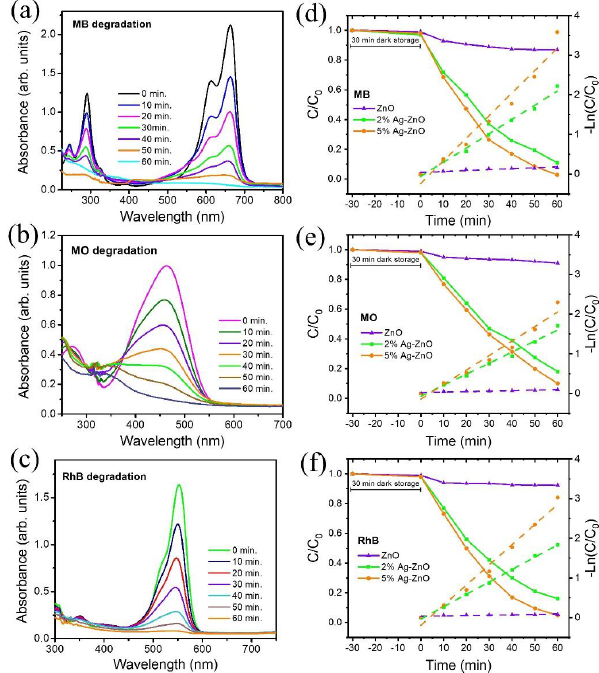
Figure 6. ( a – c ) Photocatalytic degradation performance of the 5% Ag-ZnO under visible light irradiation; ( d – f ) Photocatalytic degradation efficiency and pseudo-first-order kinetics of pure ZnO, 2% Ag-ZnO, and 5% Ag-ZnO for MB, MO, and